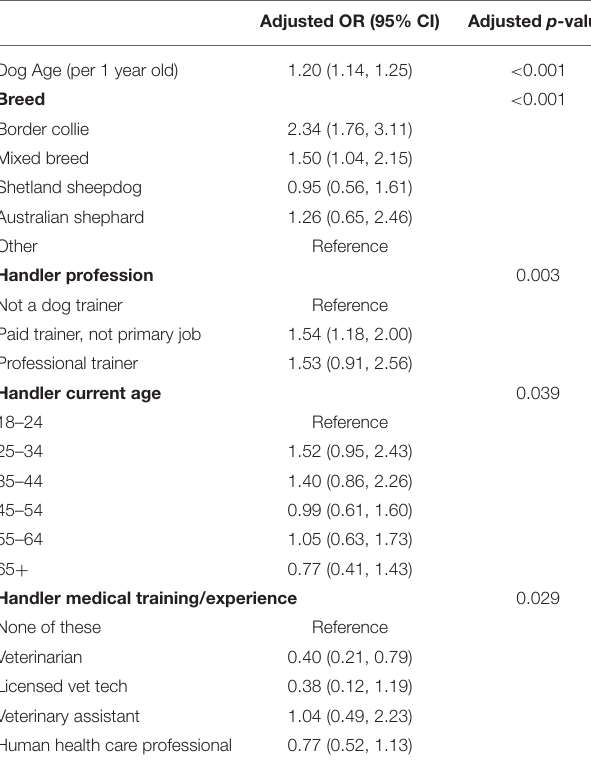
TABLE 3 | Coefficients from final adjusted model of risk factors of any injury using the North American sample.